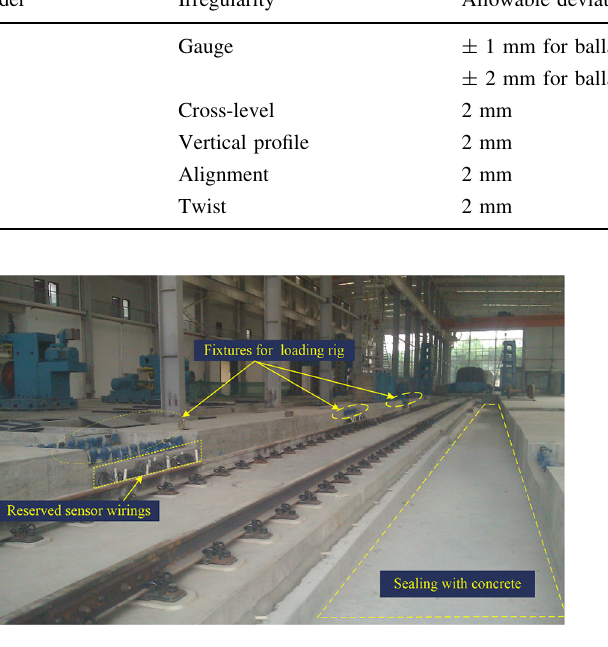
Fig. 9 Constructed track–subgrade system for Chinese high-speed railways